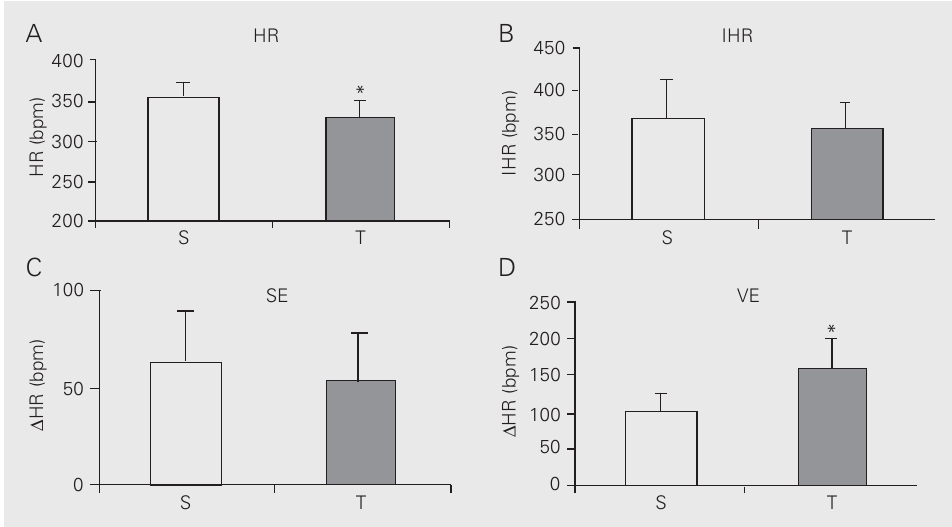
Figure 2. Cardiac autonomic control of heart rate in seden- tary (S) and swimming-trained (T) rats. A , Resting heart rate (HR); B , intrinsic heart rate (IHR); C , cardiac sympathetic effect (SE); D , cardiac vagal effect (VE). Data are reported as means ± SEM for 12 rats in each